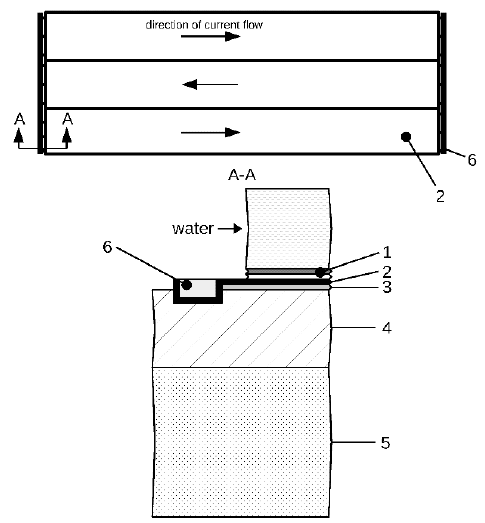
Fig. 2. Scheme of layers of heating segment of Maughan and Incropera experiment. 1 Mylar/adhesive composite, 2 steel foil, 3 transfer tape, 4 plexiglass substrate, 5 Styrofoam insulation, 6 copper bus.